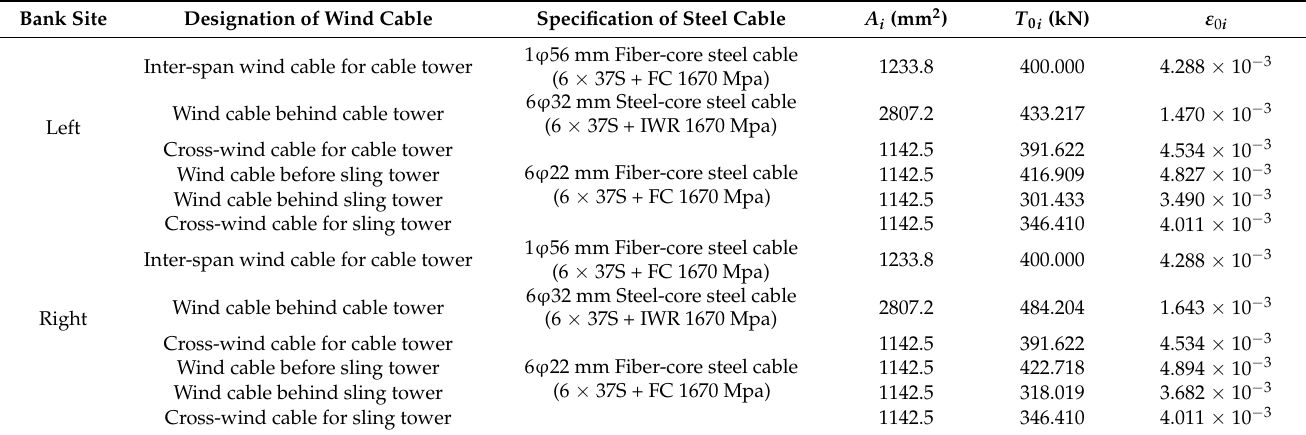
Table 3. Initial tension and initial strain of wind cable on